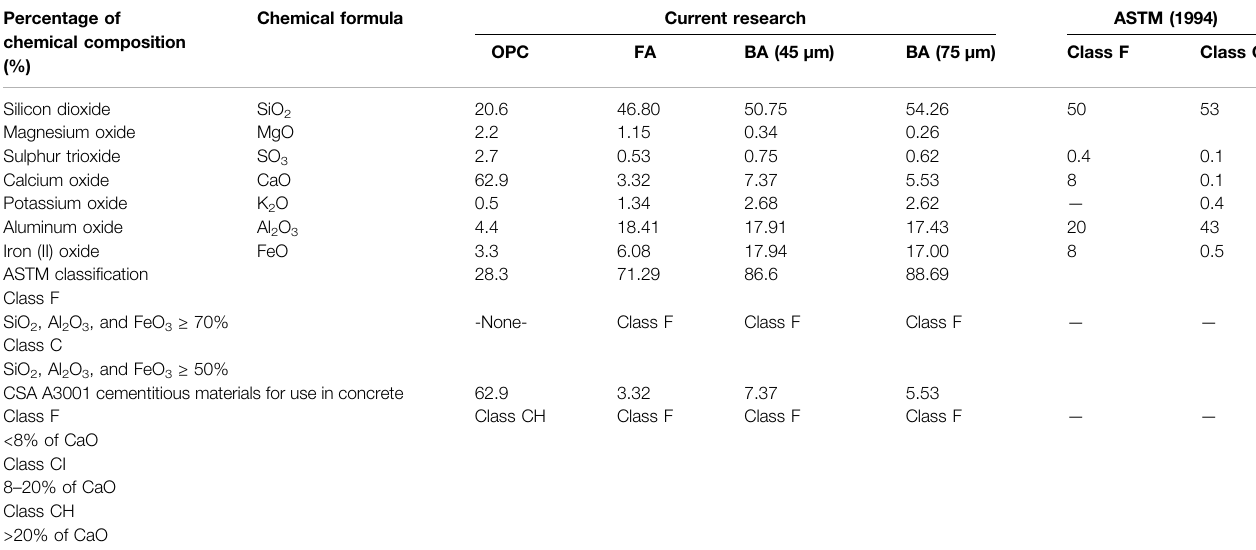
TABLE 5 | Chemical oxide content in OPC, FA, and CBA (45 and 75 µm) and selected properties of FA (class F and class C according to ASTM 1994). Percentage of Chemical formula chemical composition (%)